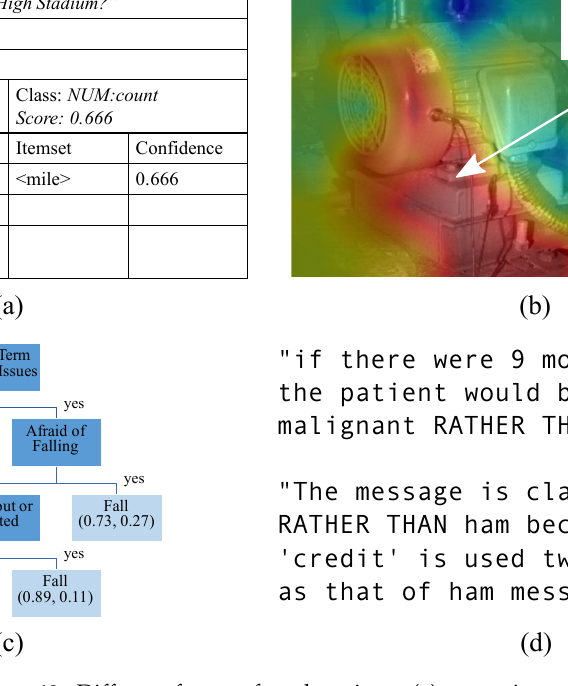
Figure 12. Different forms of explanations: ( a ) numeric explanation of remaining life estimation in industry appliances [49]; ( b ) visual explanation for fault diagnosis of industrial equipment by Sun et al. [140]; ( c ) example of rule-based explanation in the form of a tree [127]; and ( d ) explanation text generated with GRACE, proposed by Le et al.